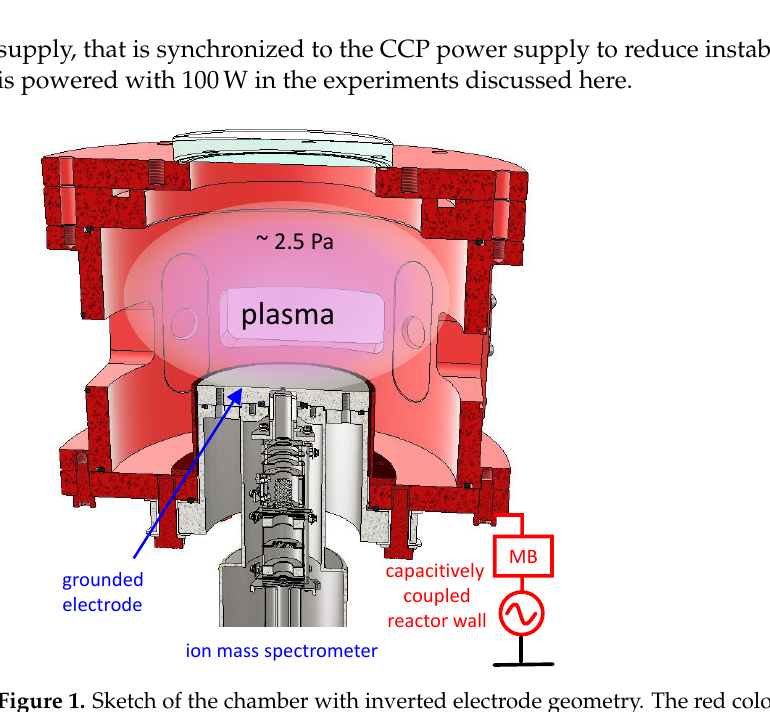
Figure 1. Sketch of the chamber with inverted electrode geometry. The red color represents the parts driven by the rf voltage, grounded parts are sketched in grey. The parts are electrically isolated by a 1mm PTFE spacer. Some windows, screws, other small parts, and the grounded shielding cage are not shown.